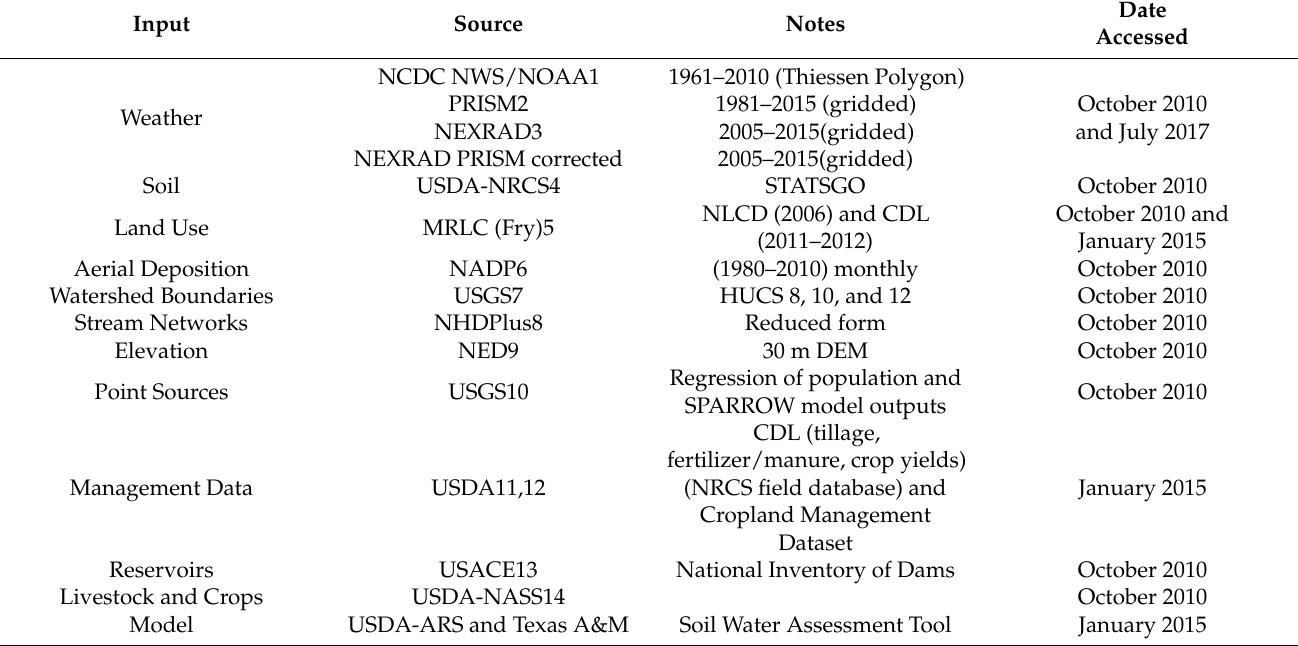
Table A4. HAWQS bibliography